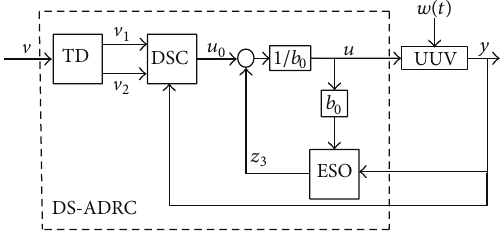
Figure 3: Design of the DS-ADRC